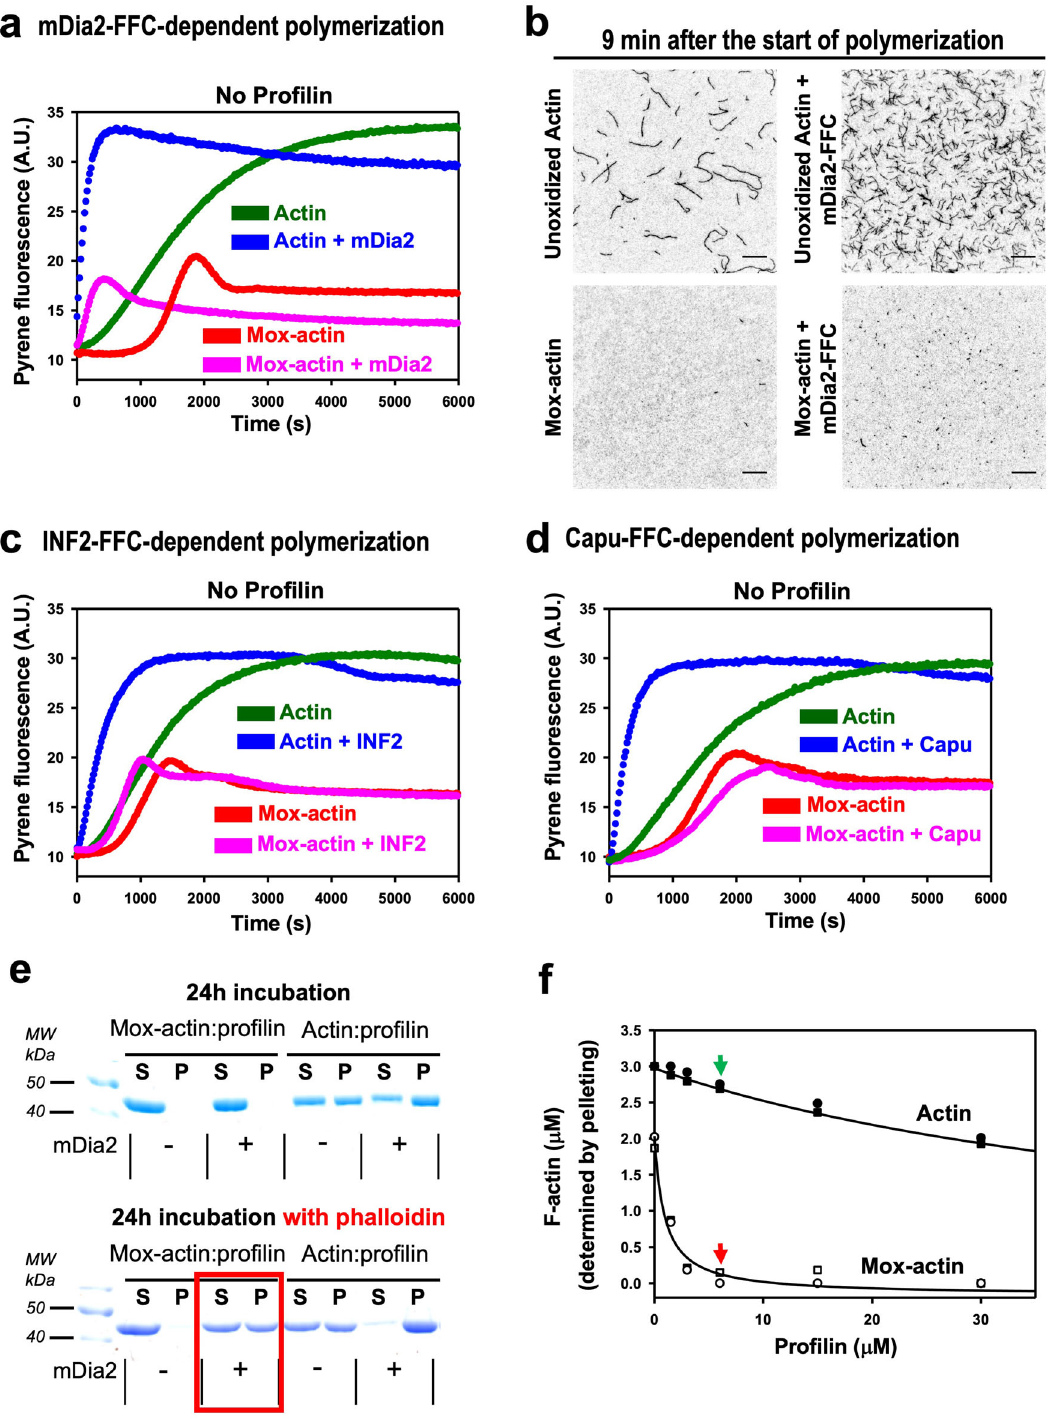
— and are — present in the reaction (Fig. 3f). In total, therefore, our results with puri fi ed proteins indicate that: (i) pro fi lin binding to Mox-actin inhibits pro fi lin-assisted actin polymerization, and (ii) pro fi lin preferentially destabilizes Mox-actin fi laments. Mical and pro fi lin functionally interact in vivo to induce F-actin and cellular remodeling . In light of our observations with Mical-oxidized actin and pro fi lin in vitro using puri fi ed proteins, we wondered if similar combined effects of Mical and pro fi lin were